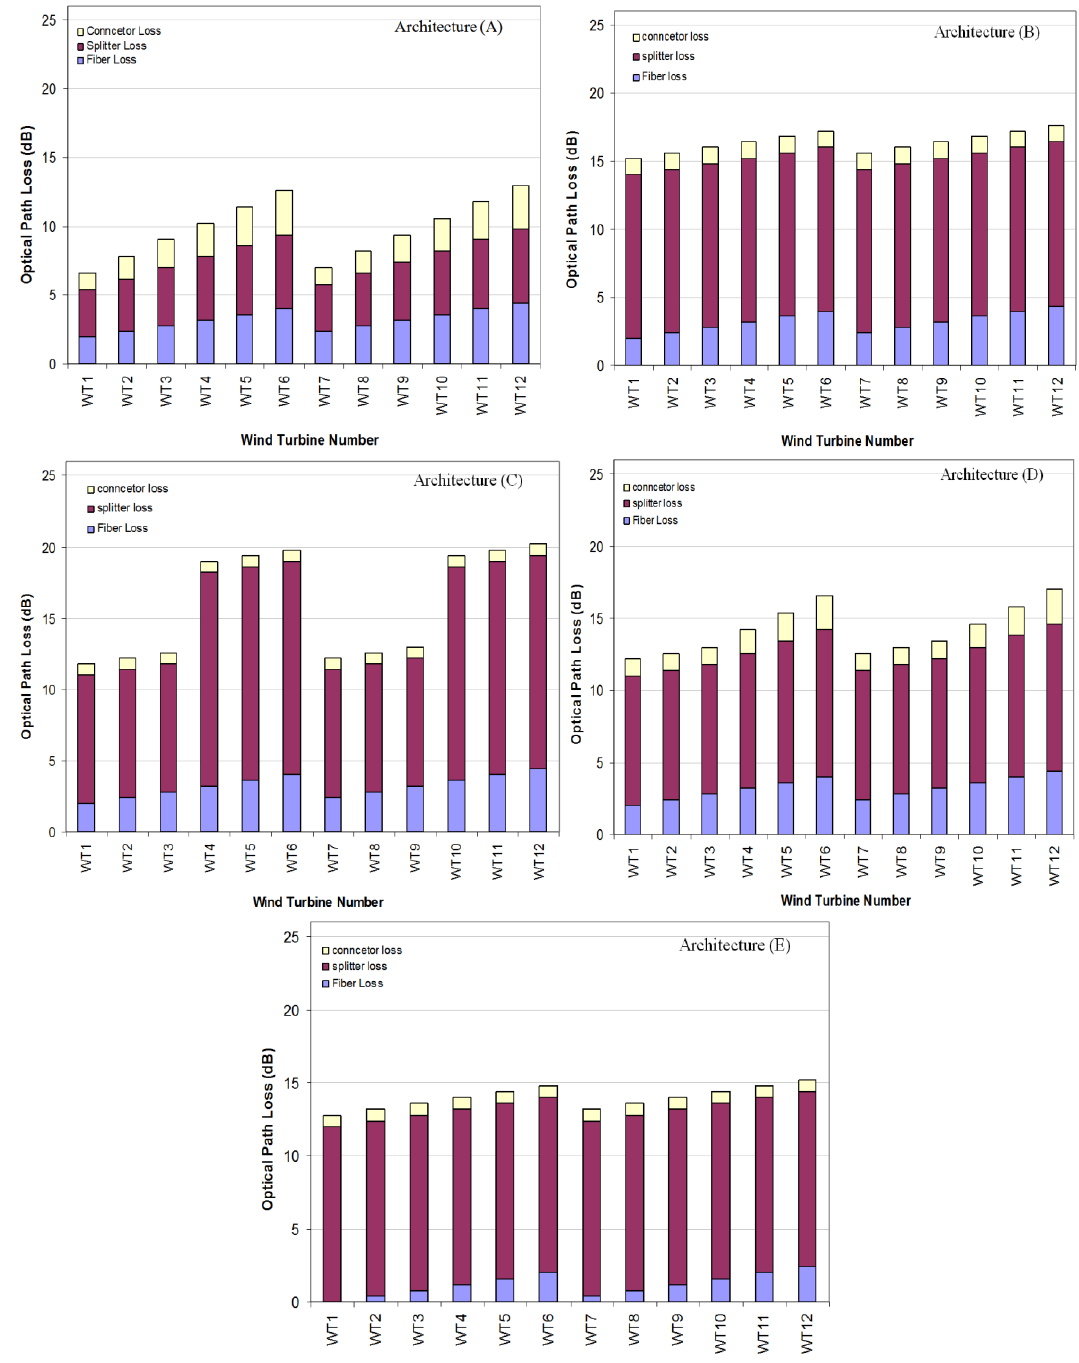
Figure 8. Total optical path loss for different architectures.